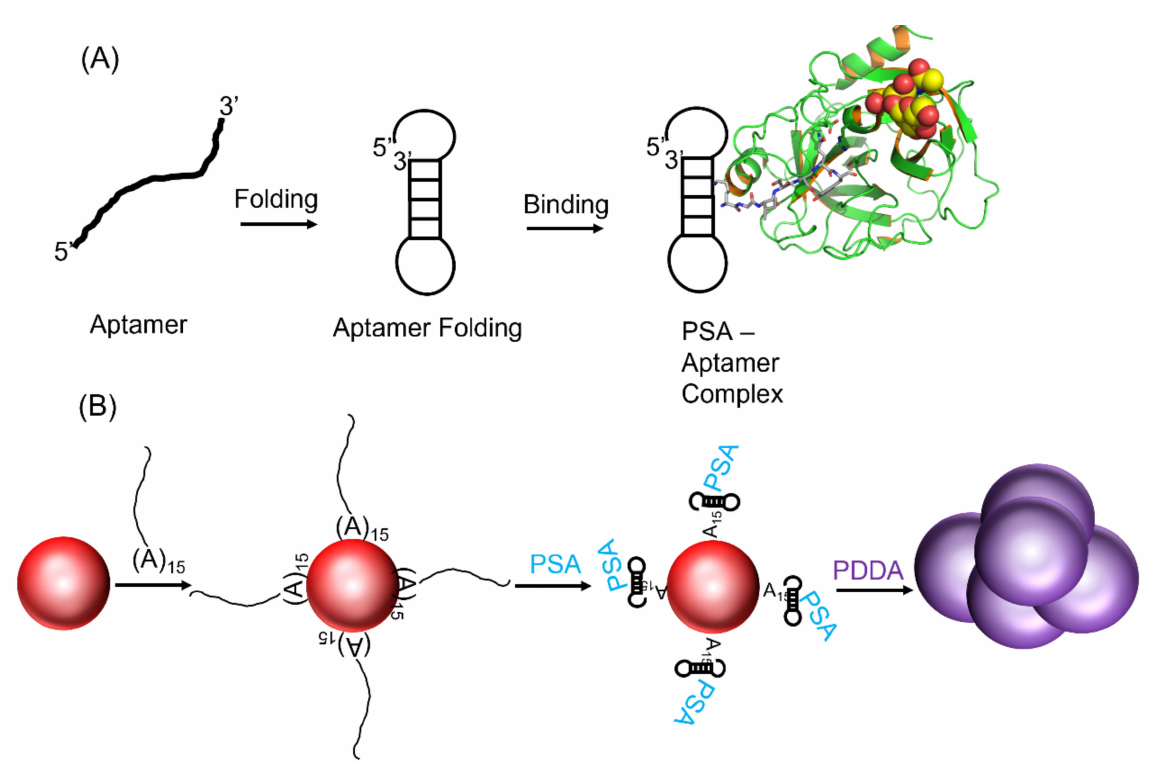
Figure 11. ( A ). Schematic representation of aptamer binding to PSA depending on structure formation. After the adjustment of the binding conditions, the aptamer folds into a 3D structure, upon which it interacts with the PSA molecule resulting in a stable PSA–aptamer complex. ( B ). Schematic diagram of the colorimetric aptasensor for PSA detection based on PDDA-induced aggregation of AuNPs. In the absence of PSA, aptamers are adsorbed on the surface of AuNPs by specific noncovalent nucleotide adsorption. In the presence of PSA, the aptamer interacts with the PSA and free PDDA caused aggregation of the AuNPs. Reprinted with permission from ref. [116]. Copyright 2020,